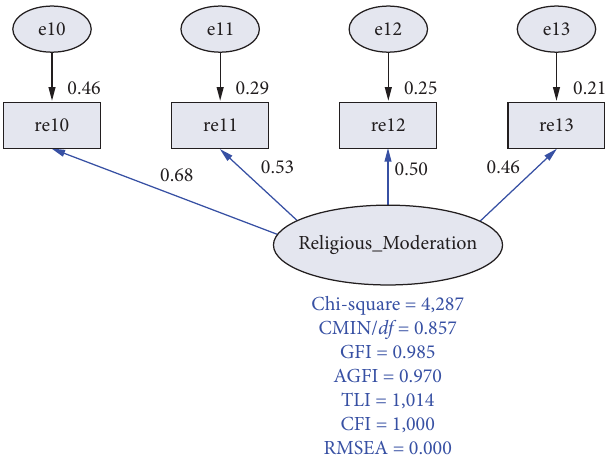
F IGURE 3: Diagram and output of the AMOS 24 application for the religious moderation